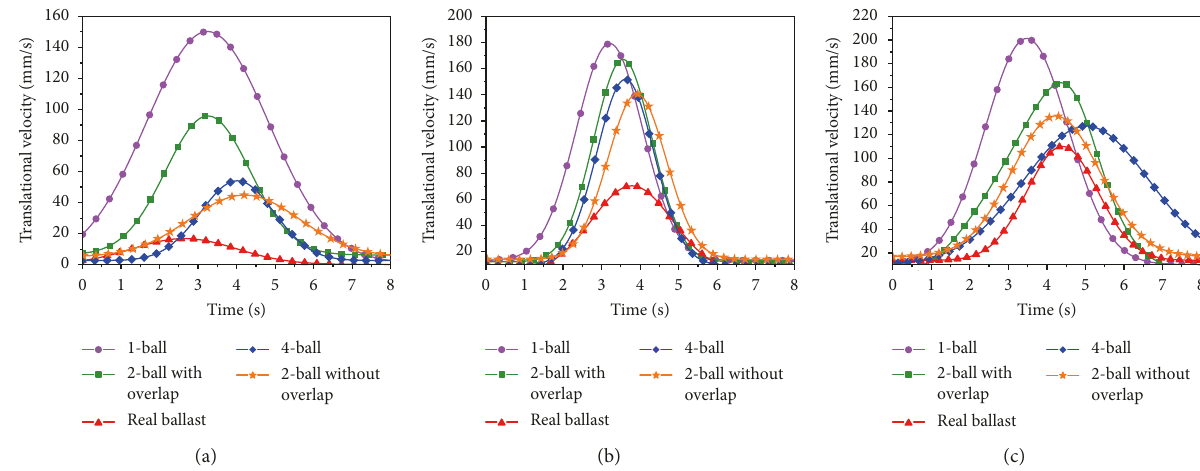
Figure 15: The translational velocities for particles located at different parts of the cylinder. (a) Bottom part. (b) Middle part. (c) Upper part.